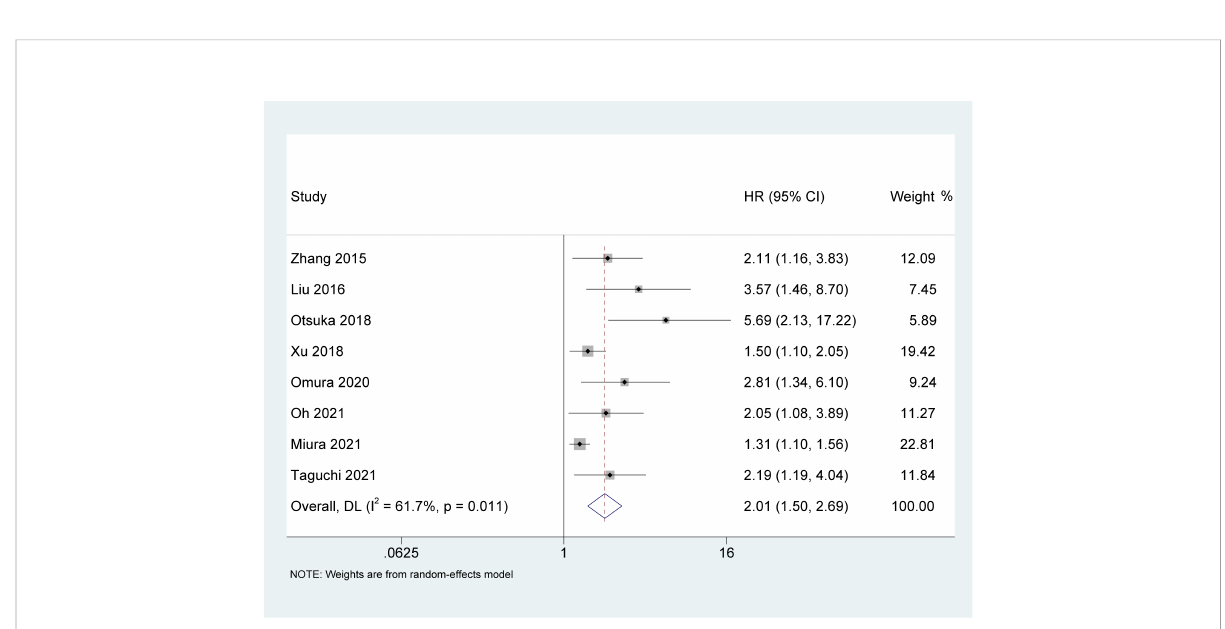
FIGURE 3 Forest plot and meta-analysis of the association between cancer-speci fi c survival and albumin to globulin